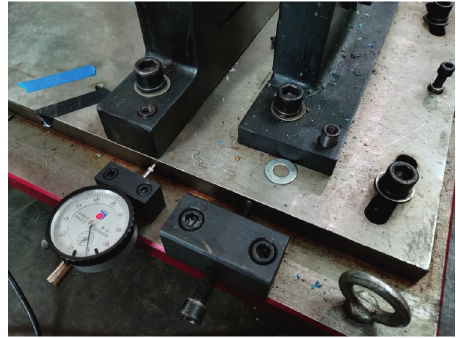
Figure 8: Imbalanced counterweight bolt.